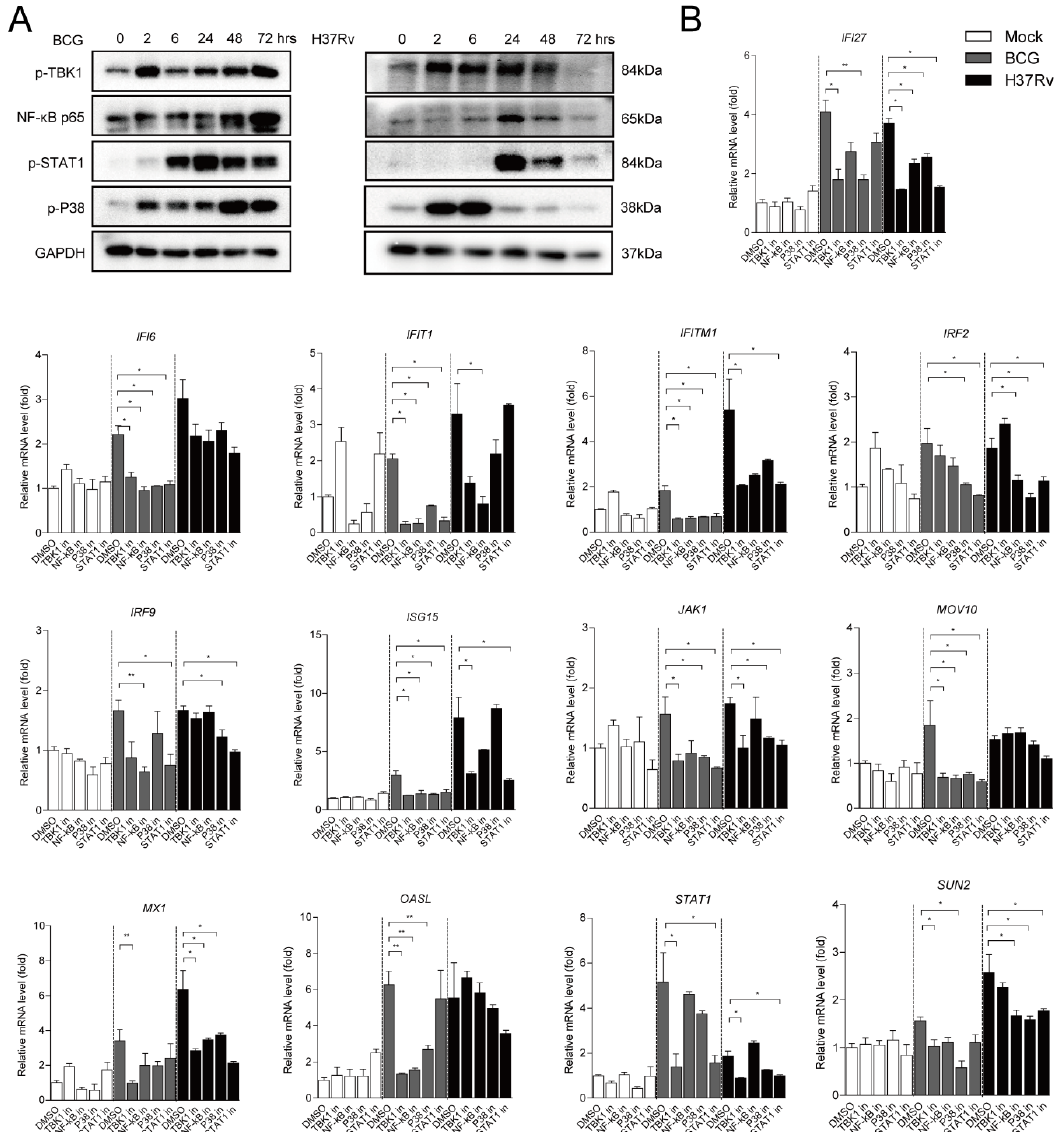
Figure 3. Mtb-mediated ISG production is selectively induced by TBK1, NF- κB, MAPK , and JAK-STAT signaling pathways. ( A ) Upon BCG and H37Rv (MOI = 2) infection for 0, 2, 6, 24, 48, and 72 h, p-TBK1, NF- κB p65, p -p38 MAPK, and p-STAT1 proteins were determined by Western blot analysis. GAPDH protein served as an internal reference. ( B ) Well-established inhibitors including 2 μM TBK1 inhibitor BX795, 100 μM NF - κB inhibitor JSH - 23, 10 μM p38 MAPK inhibitor SB203580, and 10 μM STAT1 inhibitor fludarabine were used to treat BCG-uninfected (white columns), BCG-infected (gray columns) and H37Rv-infected (black columns) hMDMs for 24 h. Data are expressed as mRNA fold change relative to untreated cells. GAPDH served as an internal reference. (Data presented as mean ± SEM, n = 3 independent experiments with each 1 – 2 replicates). * p < 0.05 and ** p < 0.01 were considered as statistically significant.